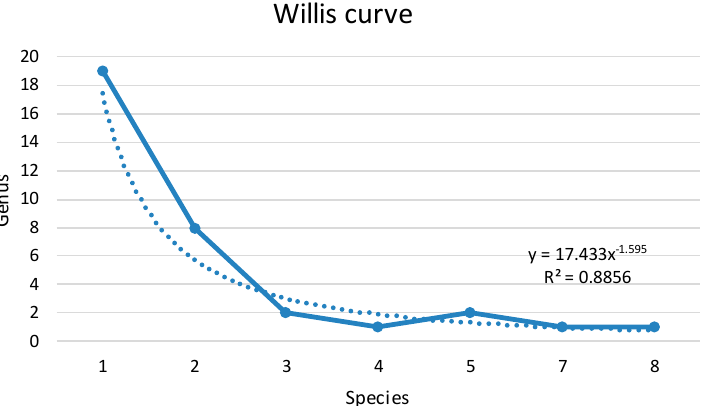
Figure 3. The Willis curve: distribution of genera number over species number in the diatom flora of the Avusor Great Lake (AGL) and Koçdüzü Great Lake (KGL). Dotted line is the trend line with R 2 = 0.8856.